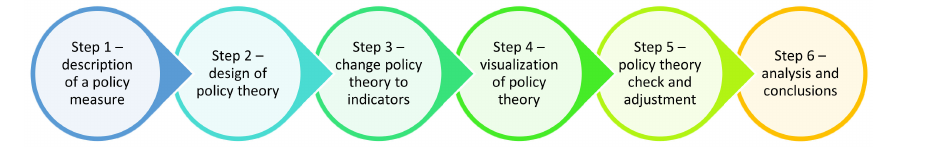
Figure 1. Theory-based policy analysis